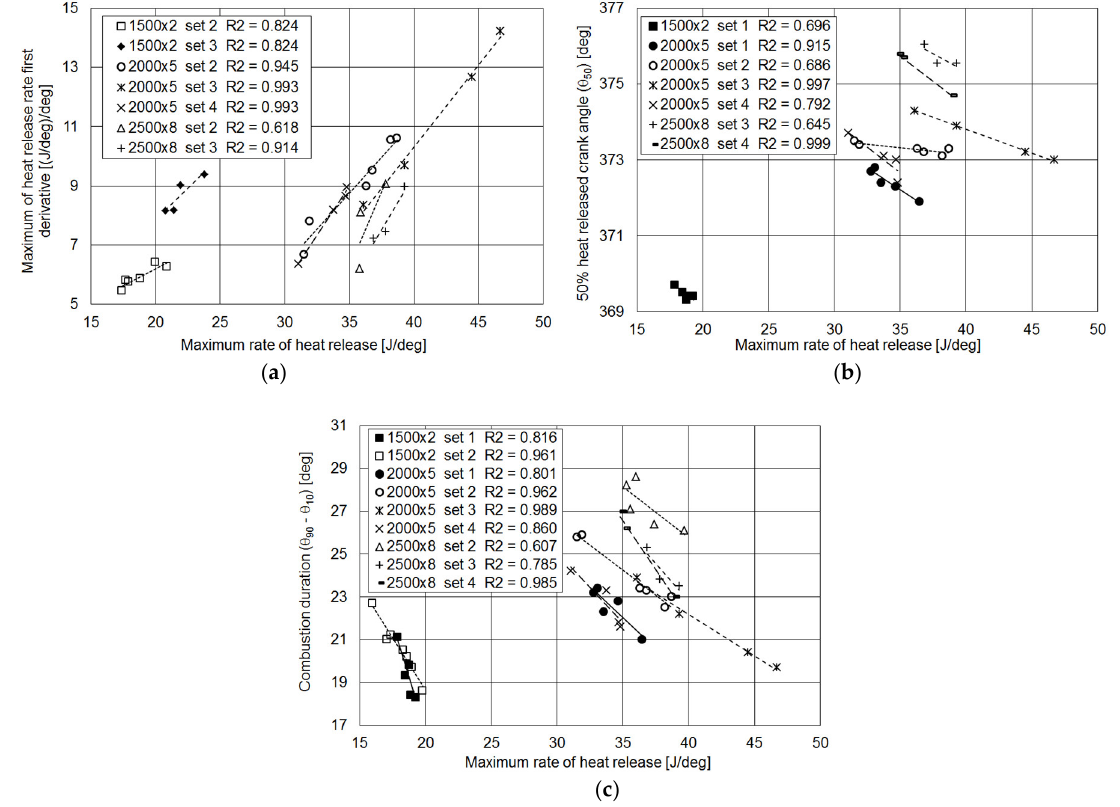
Figure 8. Relationship between RoHR MAX and (dRoHR/dθ) MAX ( a ), θ 50 ( b ), (θ 90 – θ 10 ) ( c ) in different test sets.